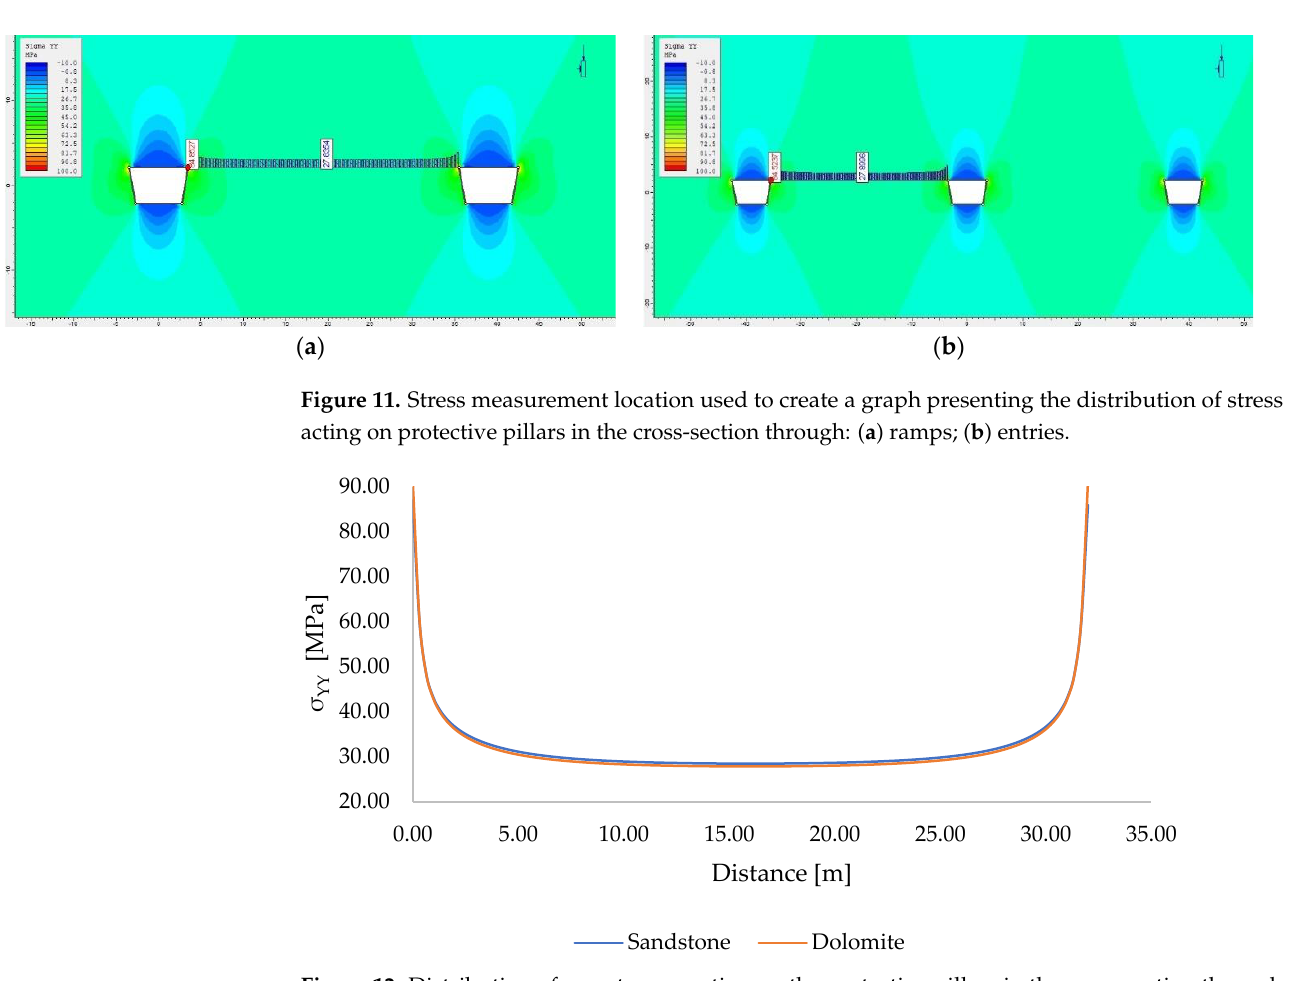
Figure 10. Distribution of σ YY stresses acting on the excavation roof in the cross-section through the ( a ) ramps and ( b ) entries drilled in sandstone and dolomite.